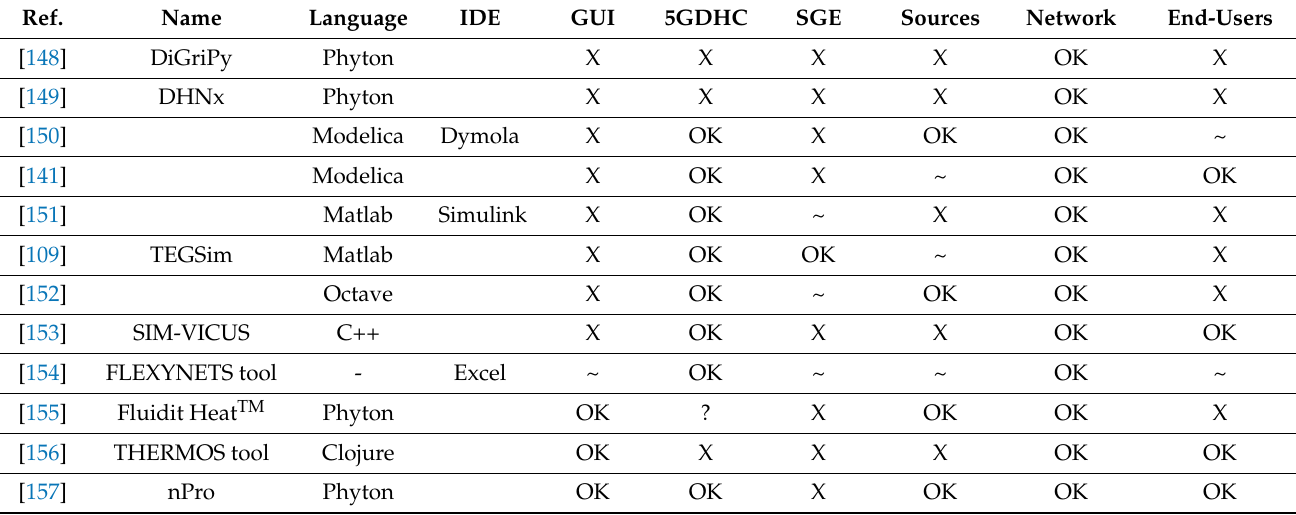
Table 1. Review of modeling tools suitable for 5GDHC design.